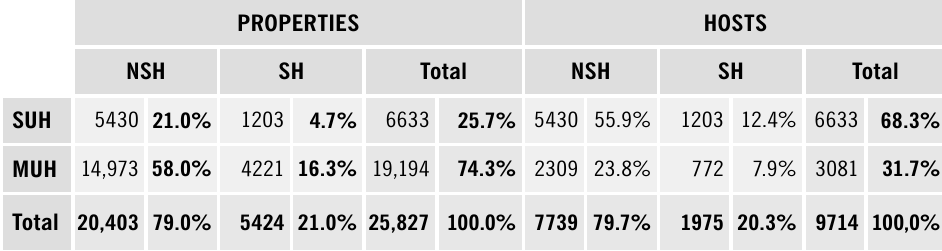
Table 1. Multi-unit host, superhost property characteristics and hosts